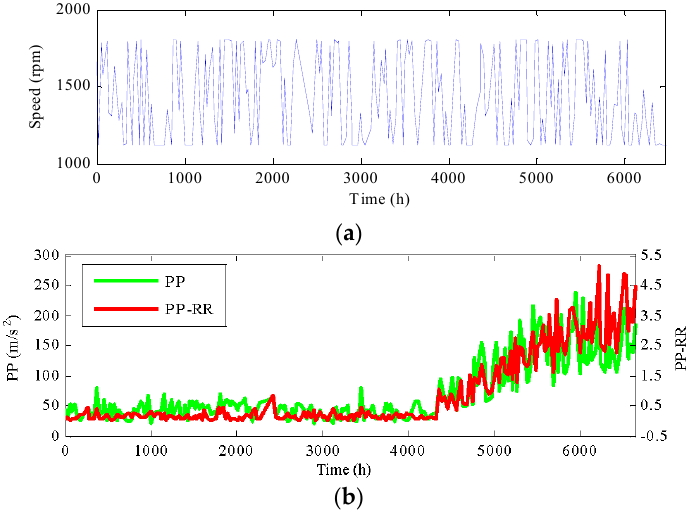
Figure 9. The comparison result: ( a ) the generator speed during whole life cycle; ( b ) PP and PP-RR.